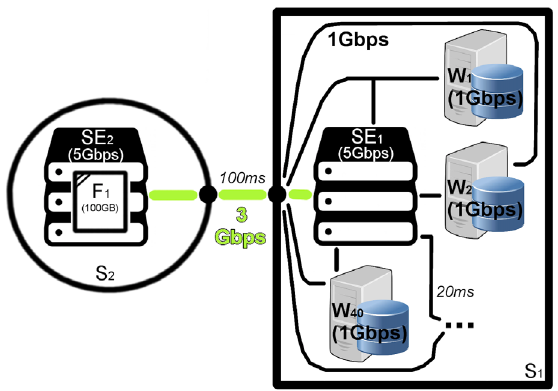
Figure 1. Example grid